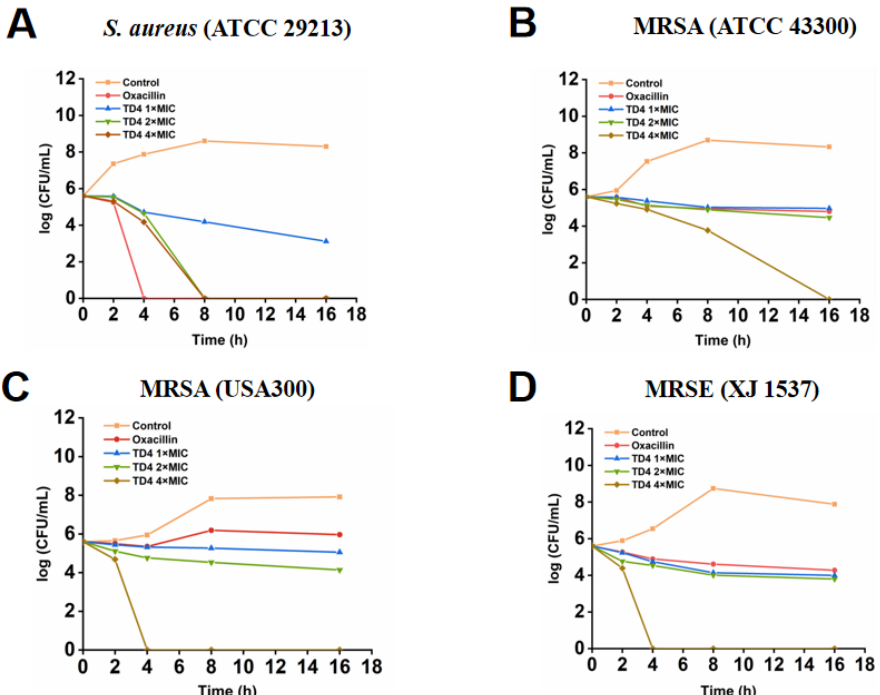
Figure 2. Inhibitory activity of TD4 on bacterial colonies of ( A ) S. aureus (ATCC 29213), ( B ) MRSA (ATCC 43300), ( C ) MRSA (USA 300) and ( D ) MRSE (XJ 1537).